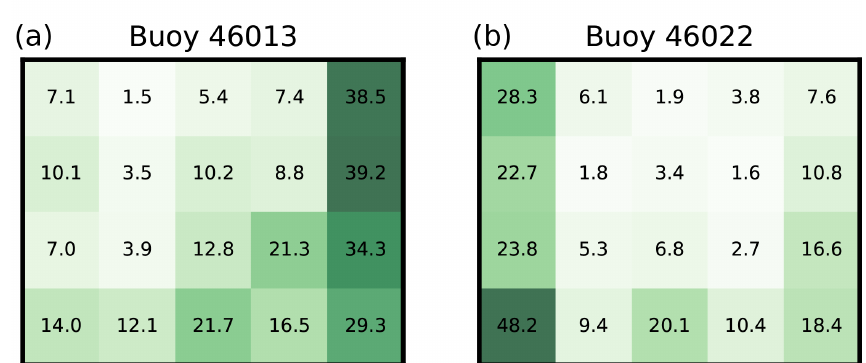
Figure 4. Percentage of southerly flow hours recorded at each buoy site along the California coastline for each node in the 4 × 5 SOM topology: (a) buoy 46013 (Bodega Bay; 38.238 ◦ N, 123.307 ◦ W) and (b) buoy 46022 (Eel River; 40.712 ◦ N, 124.529 ◦ W).